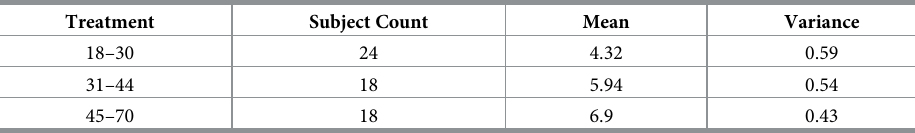
Table 25. Data summary—Viewpoint #9.